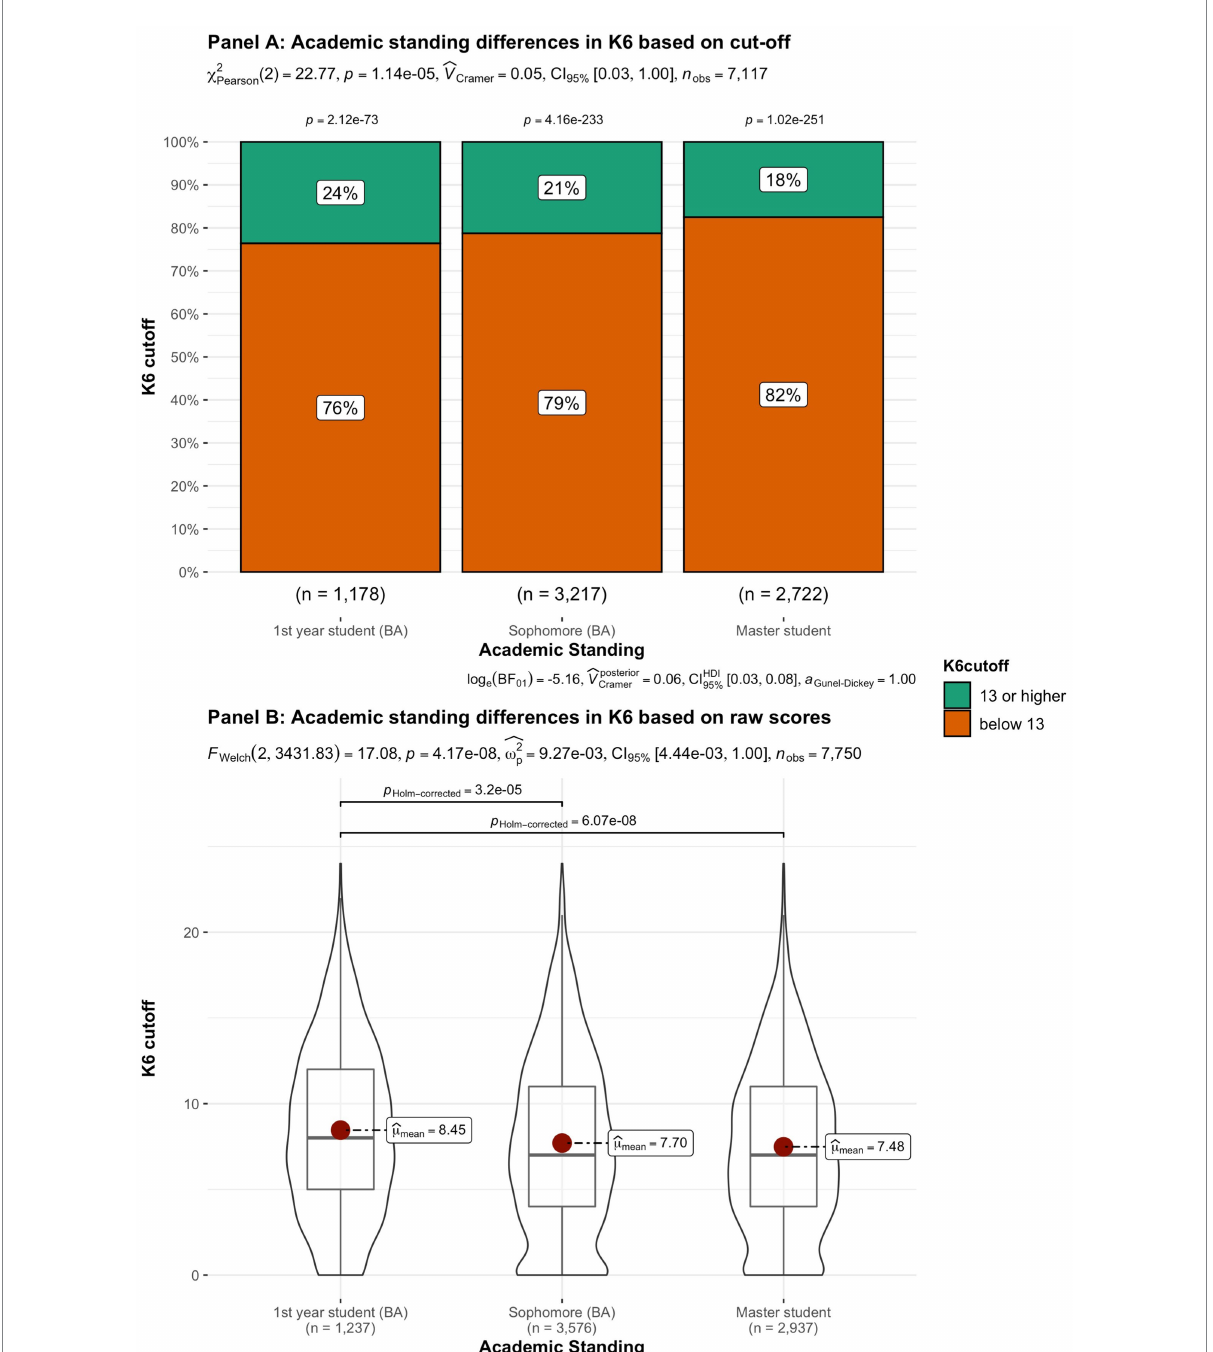
FIGURE 12 Summated scores on the K6 (indicator of mental illness and considered as a cutoff variable) across student subgroups in terms of academic